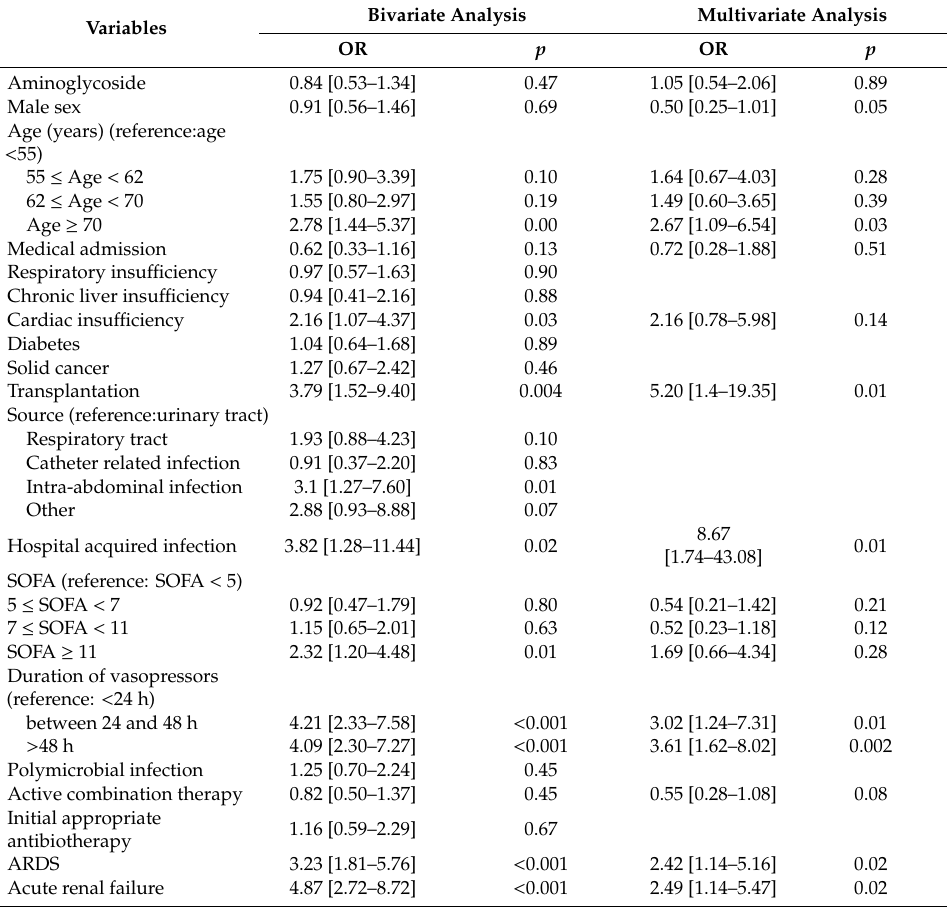
Table 4. Bivariate and multivariate analysis of risk factors associated with 30-day